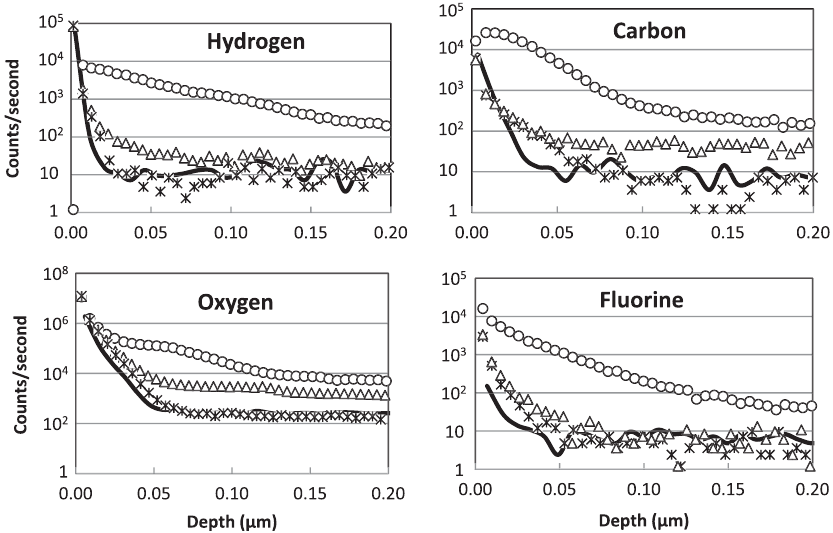
FIG. 8. SIMS analysis of the unused (solid line) and used strained superlattice wafers (open data points) show an increase in implantation as a function of depth for most SIMS analysis positions on the photocathode. Positions were unable to be directly correlated to operational positions, but for all species, open circles (o) are believed to be at the electrostatic center, data indicated by an x is believed to be from a minimally damaged region and data indicated in triangles from an intermediate region. Note that the strained superlattice structure is only 100 nm thick, and implantation is seen both in and deeper than the strained superlattice